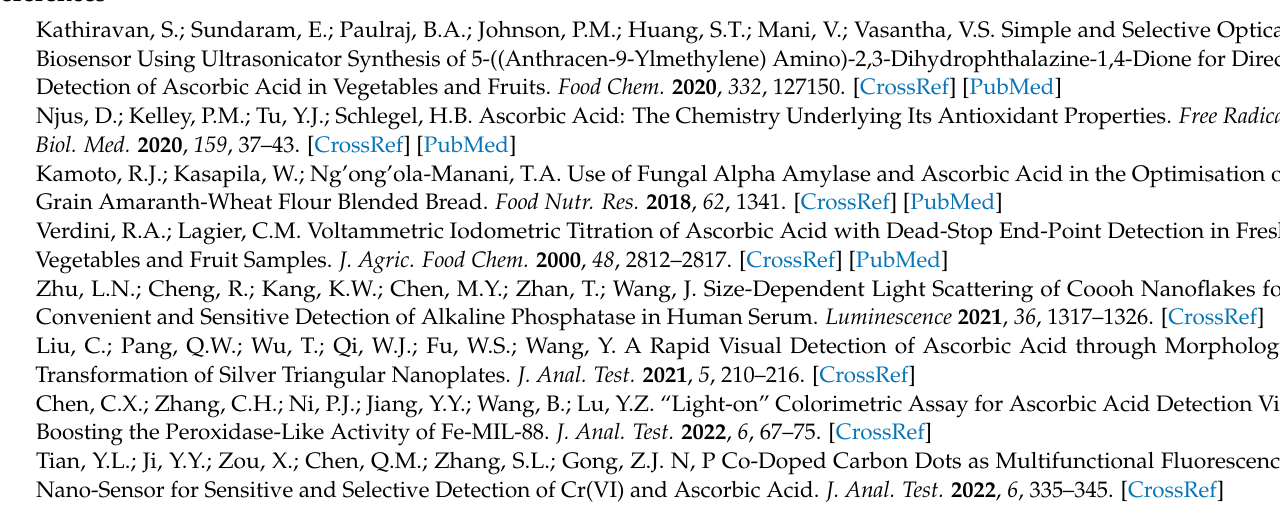
Table S1. 11 sets λ max of blank samples; Table S2. Real sample test results detected by iodometry; and Table S3. Real sample test results detected by the proposed